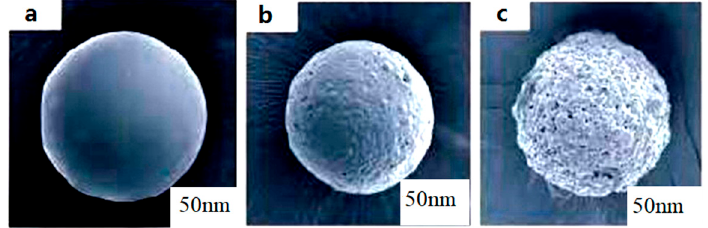
Figure 19. Electron Microscopic Scanning Image of Symmetrical Nanoparticles Microcapsule Release.